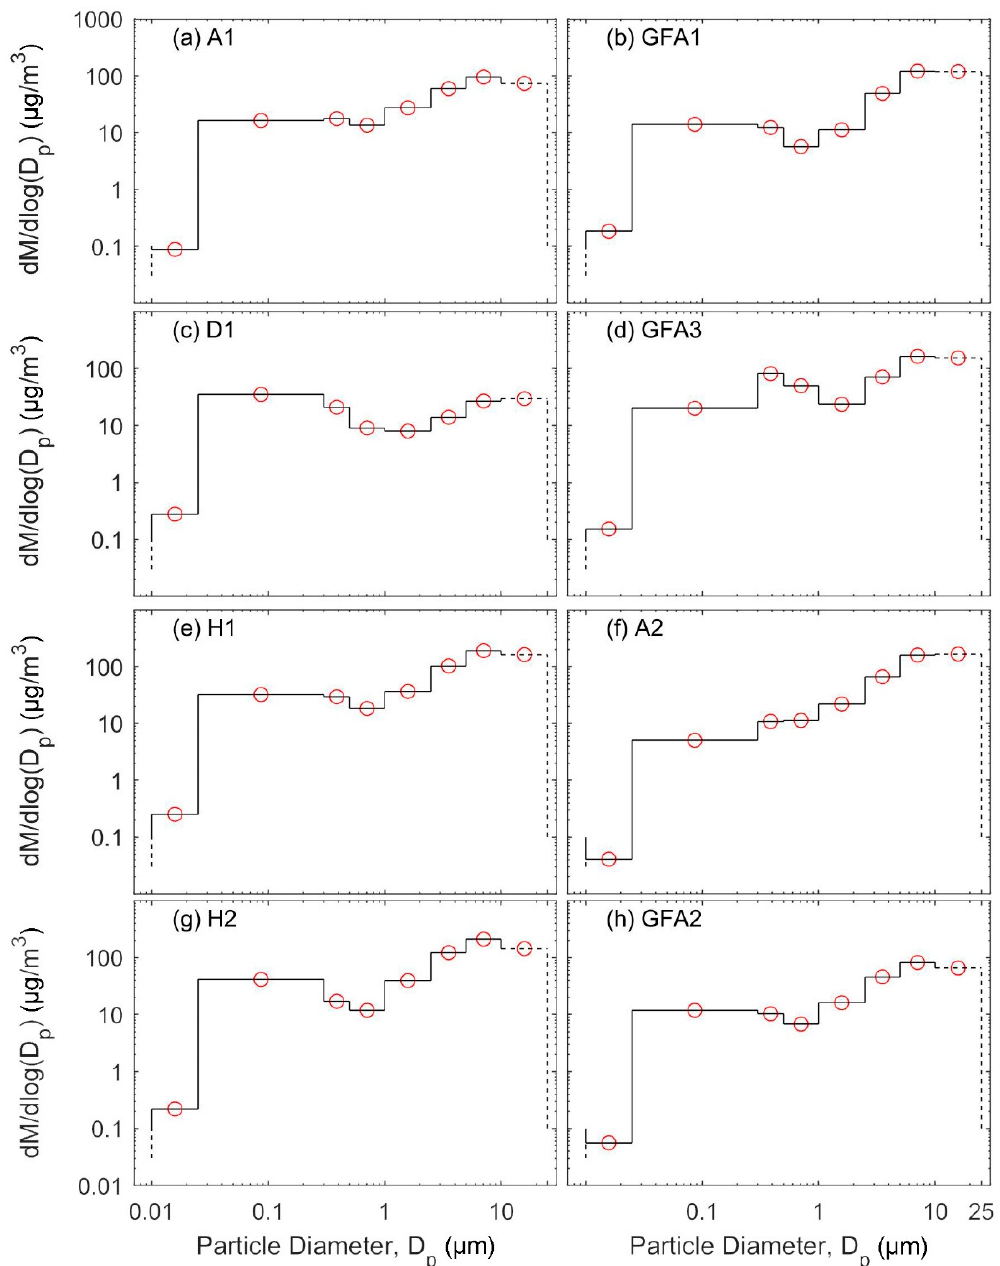
Figure 7. Mean particle mass size distributions calculated for the entirety of the winter measurement campaign at each dwelling: ( a ) apartment A1, ( b ) ground floor apartment GFA1, ( c ) duplex D1, ( d ) ground floor apartment GFA3, ( e ) house H1, ( f ) apartment A2, ( g ) house H2, and ( h ) ground floor apartment GFA2.